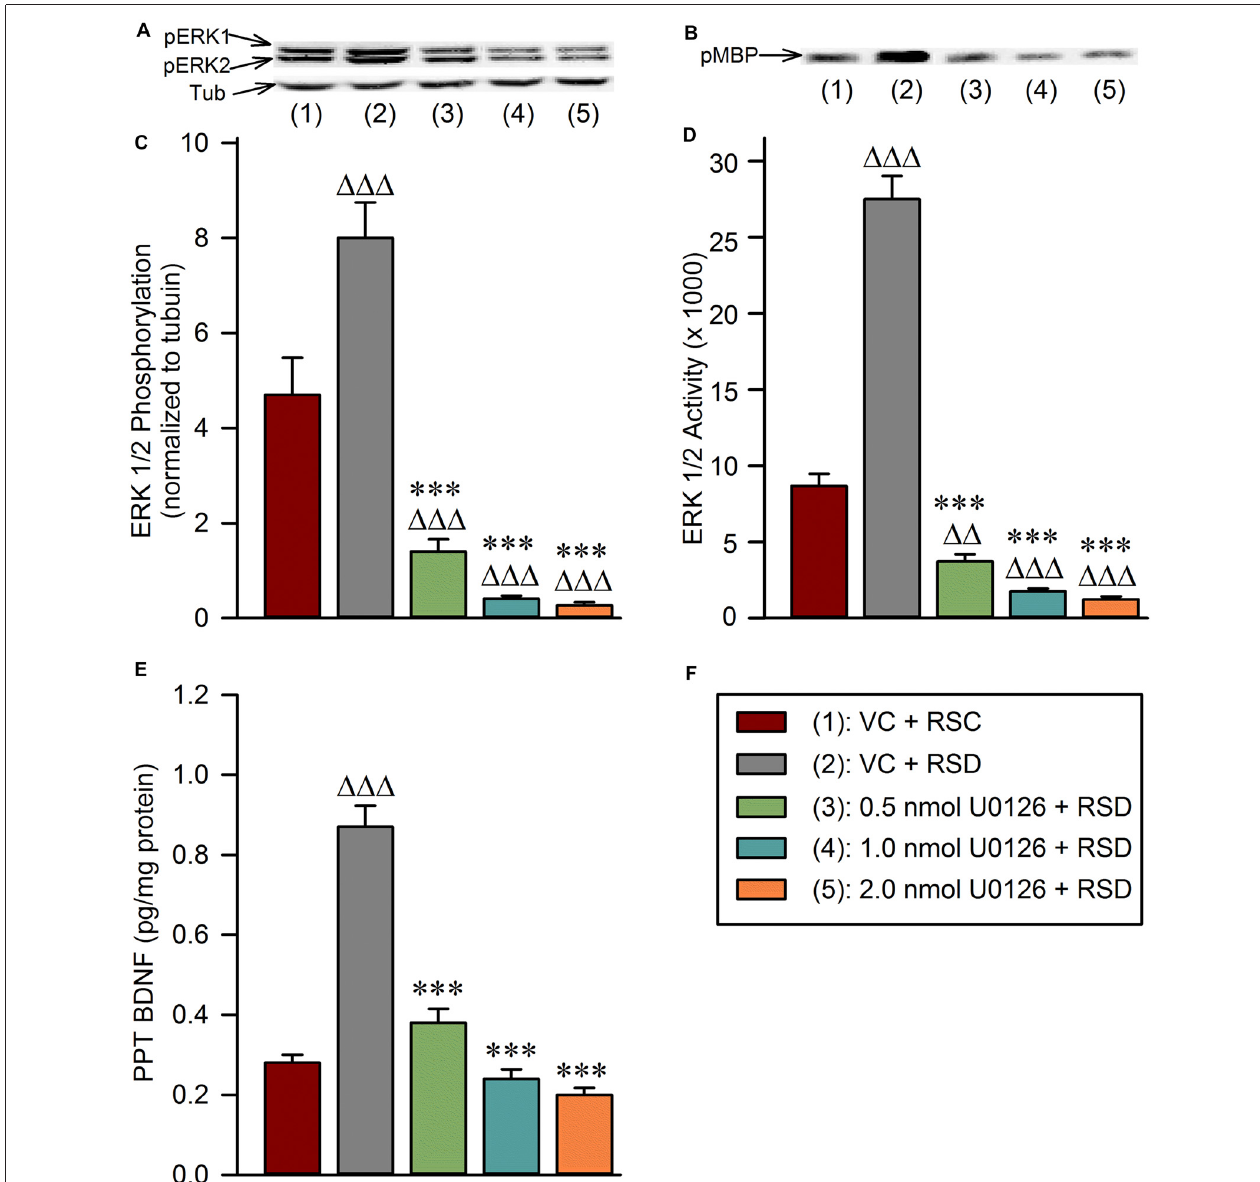
FIGURE 4 | Local application of U0126 into the PPT prevents selective REM sleep deprivation-induced increases in BDNF protein expression and extracellular-signal-regulated kinase 1 and 2 (ERK1/2) phosphorylation and activation in the PPT. (A) Representative western blots of pERK1/2 and α -tubulin in the PPT of animals in the following groups: (1) vehicle control injected unrestricted REM sleep (VC + RSC); (2) vehicle control injected selective REM sleep deprived (VC + RSD); (3) 0.5 nmol U0126 injected selective REM sleep deprived (0.5 nmol U0126 + RSD); (4) 1.0 nmol U0126 injected selective REM sleep deprived (1.0 nmol U0126 + RSD); and (5) 2.0 nmol U0126 injected selective REM sleep deprived (2.0 nmol U0126 + RSD). (B) Representative western blots of pMBP in the PPT of: (1) VC + RSC; (2) VC + RSD; (3) 0.5 nmol U0126 + RSD; (4) 1.0 nmol U0126 + RSD; and (5) 2.0 nmol U0126 + RSD. (C) Bars represent levels (mean ± SE) of phosphorylated ERK1/2 in the PPT of: (1) VC + RSC; (2) VC + RSD; (3) 0.5 nmol U0126 + RSD; (4) 1.0 nmol U0126 + RSD; and (5) 2.0 nmol U0126 + RSD. All analyses of pERK1/2 expression are normalized against α -tubulin. (D) Bars represent densitometric measurements (mean ± SE) from western blots of phosphorylated myelin basic protein (pMBP) levels in the PPT of: (1) VC + RSC; (2) VC + RSD; (3) 0.5 nmol U0126 + RSD; (4) 1.0 nmol U0126 + RSD; and (5) 2.0 nmol U0126 + RSD. (E) Bars represent amounts (mean ± SE) of BDNF in the PPT of: (1) VC + RSC; (2) VC + RSD; (3) 0.5 nmol U0126 + RSD; (4) 1.0 nmol U0126 + RSD; and (5) 2.0 nmol U0126 + RSD. (F) Key. Post hoc test (Bonferroni’s multiple comparisons test): triangle represents the comparison with vehicle control + REM sleep control (VC + RSC) and asterisk represents the comparison with vehicle control + selective REM sleep deprivation (VC + RSD). ∆∆∆ or ∗∗∗ p <